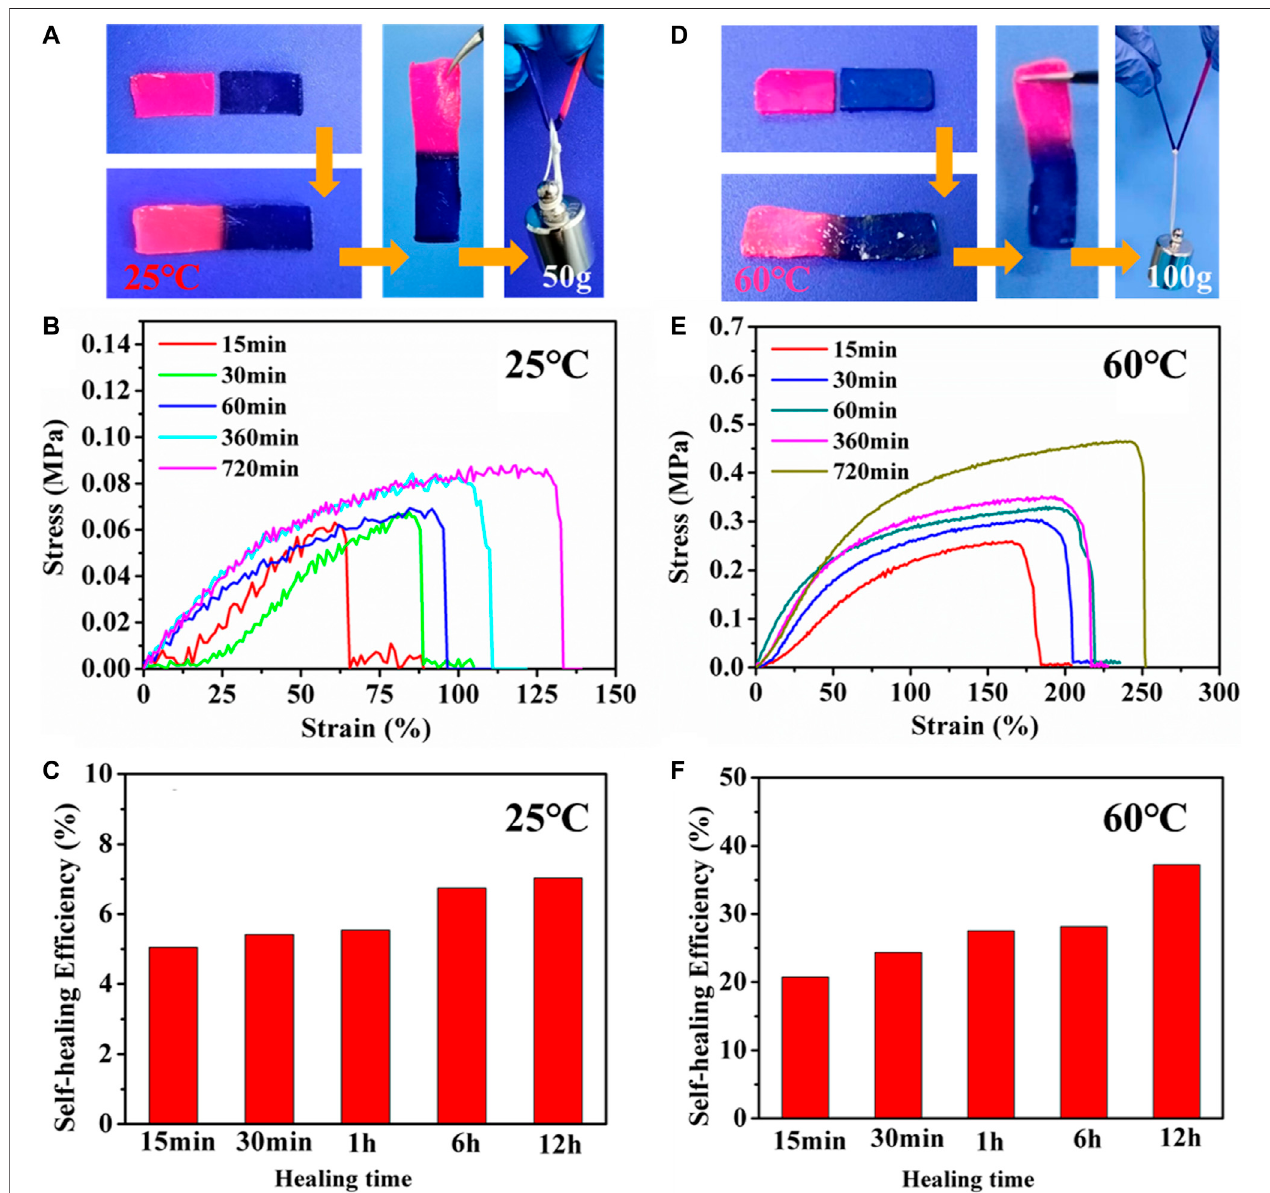
FIGURE 3 | The self-healing property of PHEAA-GE-Gl-LiCl organohydrogel. The self-healed PHEAA-GE-Gl-LiCl organohydrogel (A) at 25 ° C for 12 h and (D) at 60 ° C for 12 h could withstand a weight of 50 and 100 g, respectively. Stress-strain curve and self-healing ef fi ciency of the self-healed PHEAA-GE-Gl-LiCl organohydrogel at different healing time (B,C) at 25 ° C and (E,F) at 60 ° C.